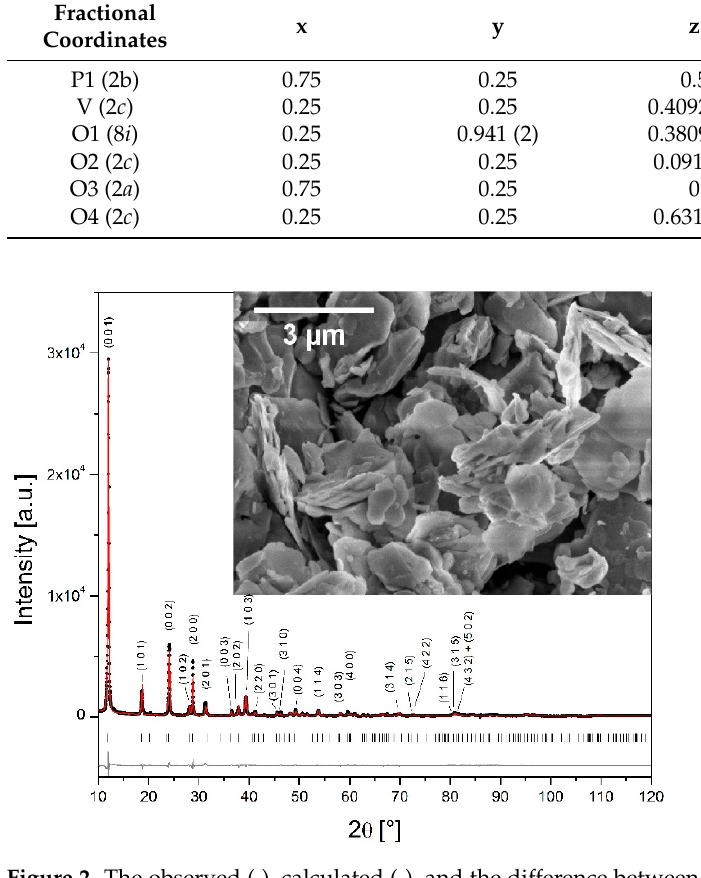
Figure 2. The observed ( · ), calculated (-), and the difference between the observed and calculated (bottom) X-ray diffraction data taken at room temperature of VOPO 4 · 2H 2 O powder. Vertical markers below the diffraction patterns indicate the positions of possible Bragg reflections. Inset: SEM micrograph of VOPO 4 · 2H 2 O powder. Table 2. Fixed and refined fractional atomic coordinates. Table 3. Selected bond distances and polyhedral